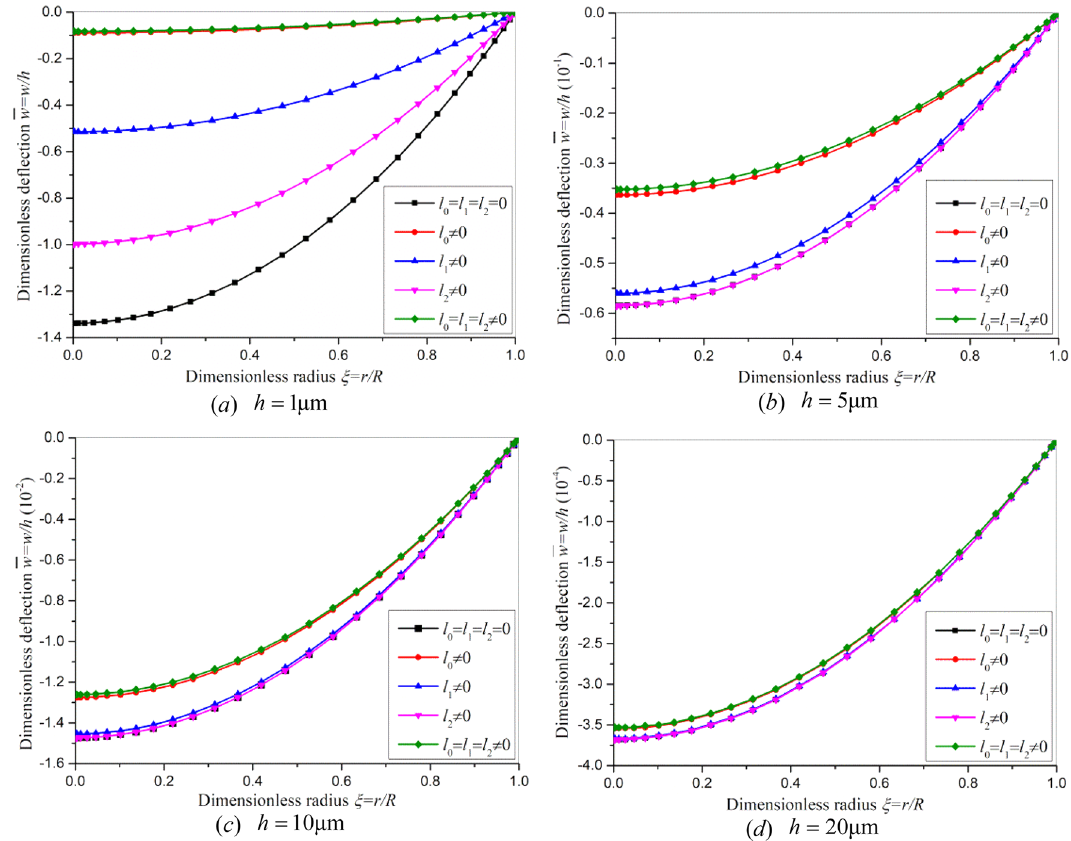
Figure 5. The dimensionless nonlinear bending deflections with q =0 and V 0 =1000 V ( a ) h = 1 μm, ( b ) h = 5 μm, ( c ) h = 10 μm, ( d ) h = 20 μm.